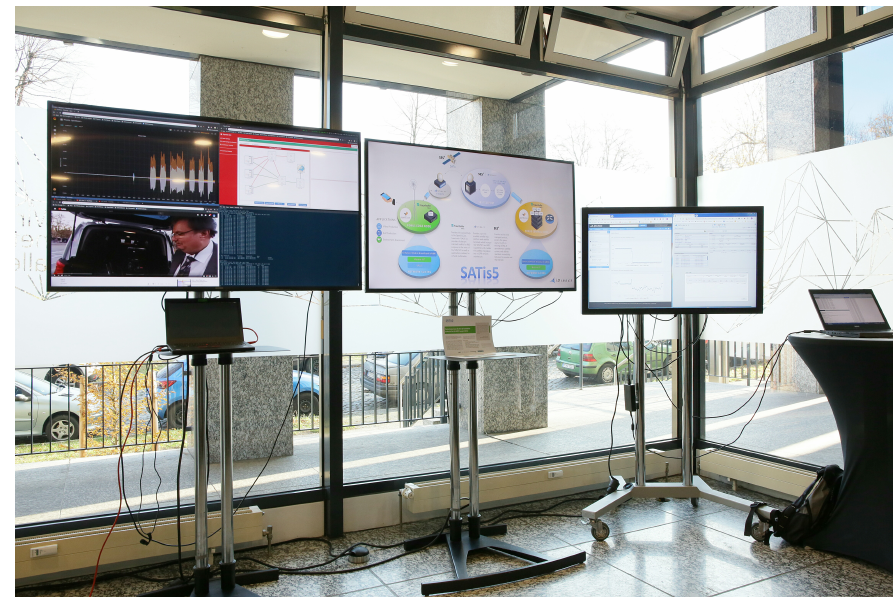
Figure 13. Showcase of the seamless satellite